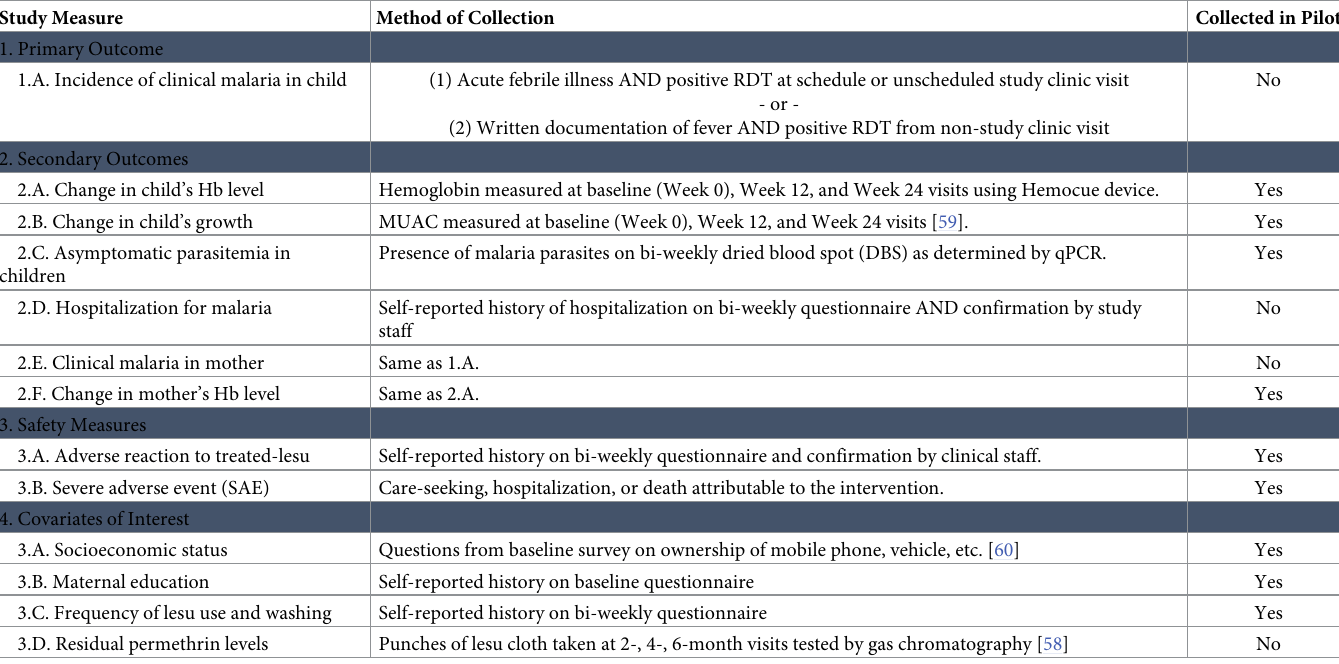
Table 1. Summary of key outcomes and collected co-variates of